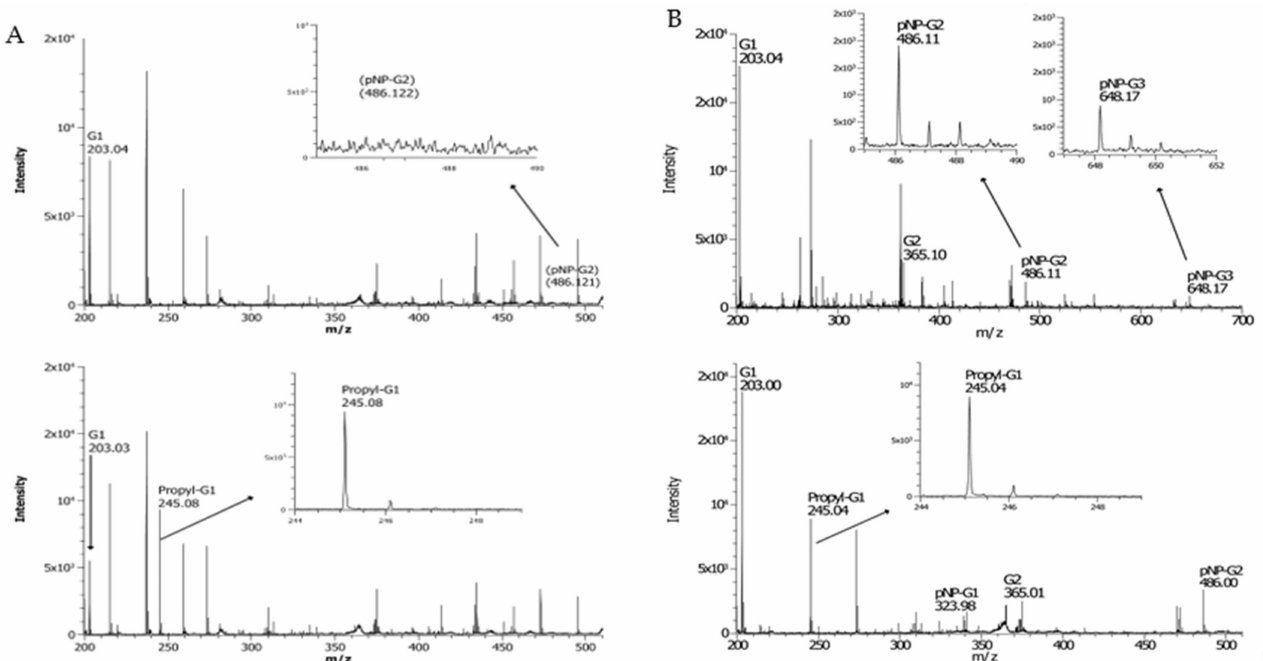
Figure 1. MALDI-TOF MS spectra of incubations with 4-nitrophenyl- α -galactopyranoside (pNP-Gal). 8 nkat/mL BoGal36A panel ( A ) or Aga27A panel ( B ) was incubated with 40 mM pNP-Gal alone (top) or with the addition of 5 v/v % propanol (bottom) at 37 ◦ C for 1 h. A peak corresponding to galactose (G1) (theoretical m / z for [m+Na + ]: 203.05) was observed in all incubations. When incubated with pNP-Gal alone, transglycosylation products were observed in the form of pNP-galactobiose (pNP-G2, theoretical m / z for [m+Na + ]: 486.12) and pNP-galactotriose (pNP-G3, theoretical m / z for [m+Na + ]: 648.18) for Aga27A but not for BoGal36A. With propanol added, both enzymes generated transglycosylation products in the form of propyl-galactopyranoside (propyl-G1) (theoretical m / z for [m+Na + ]: 245.10). Analytes and their m / z shown in parenthesis in the spectra were not detected. Table 1. Screening of transglycosylation products of Bo Gal36A and Aga27A with pNP-Gal as donor substrate and different acceptors. N.D., not detected. Acceptor Bo Gal36A Aga27A Product